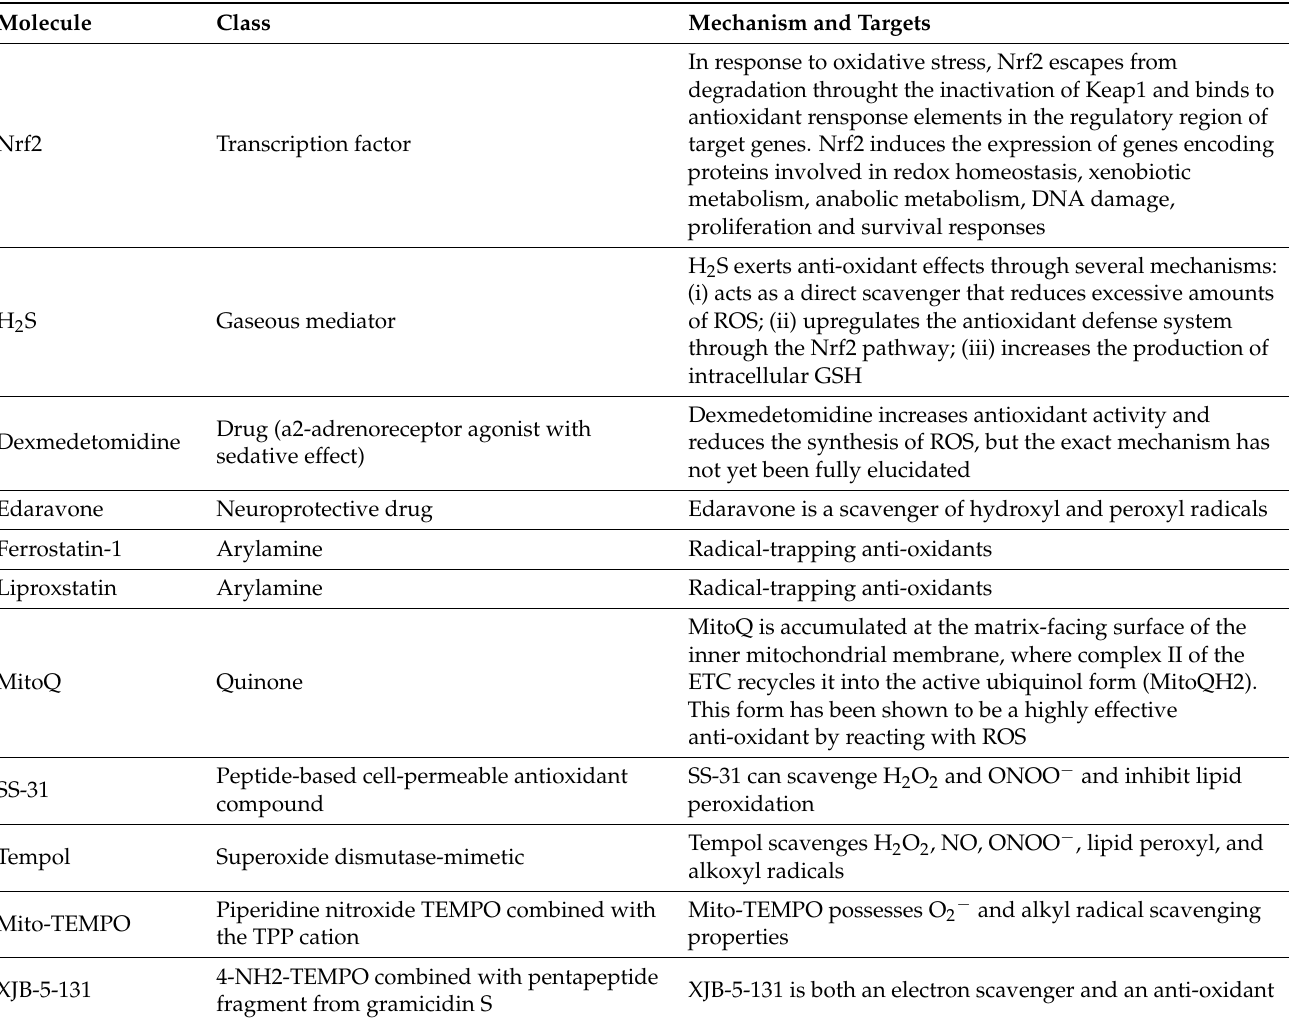
Table 1. Antioxidant molecules with their class, mechanism and